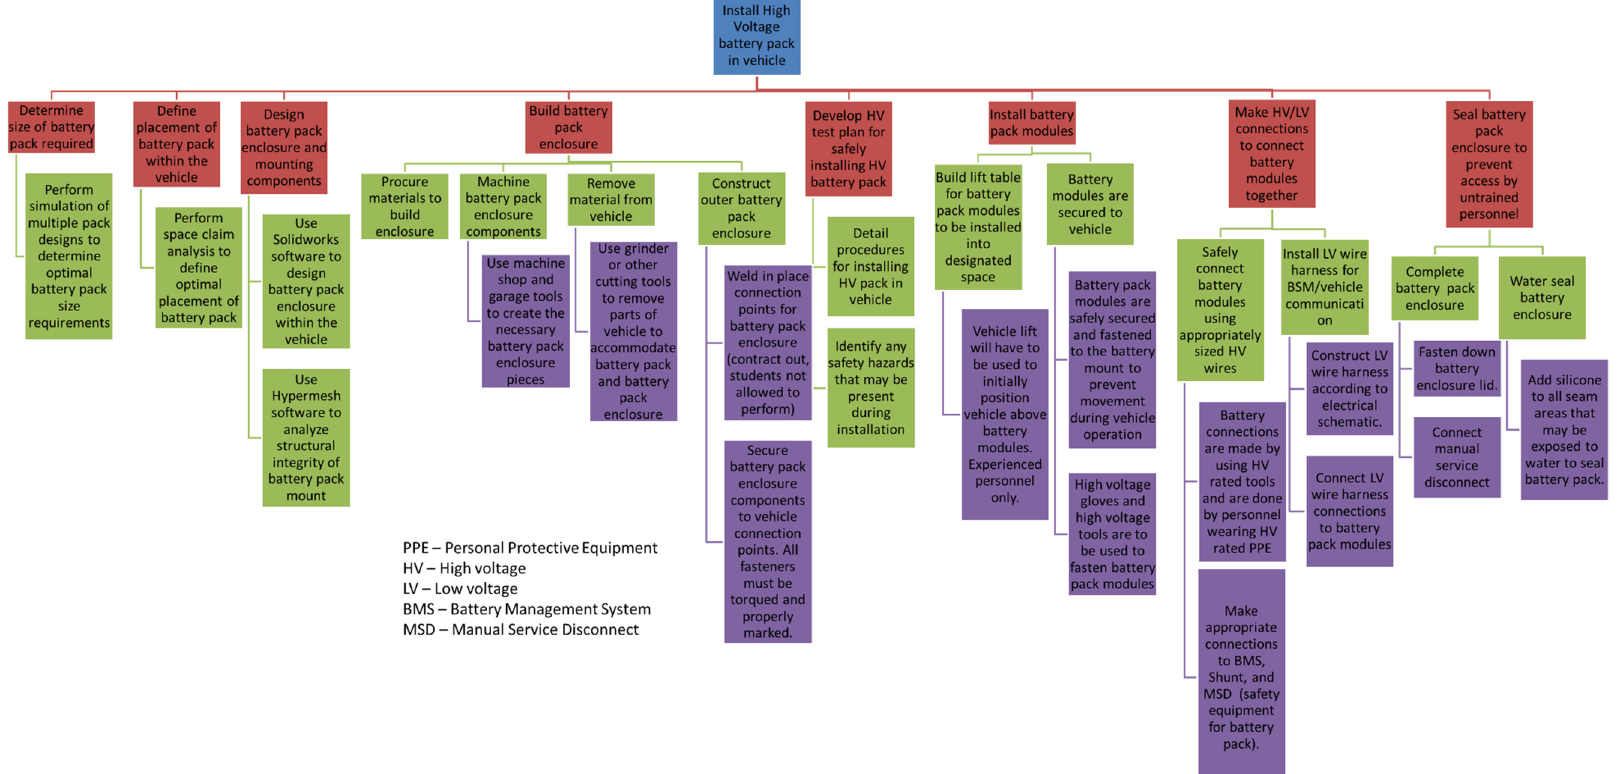
Figure A1. Hierarchal Task Analysis Example: Installation of a High Voltage (HV) Battery Pack.